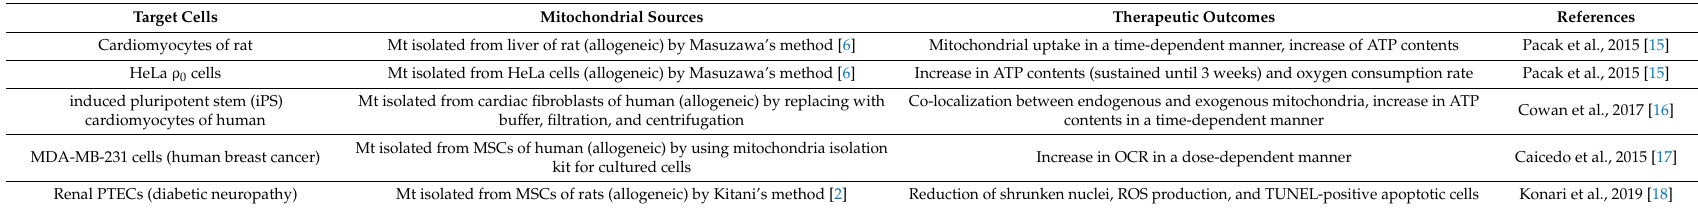
Table 3. Research reports regarding mitochondrial transplantation under cell culture